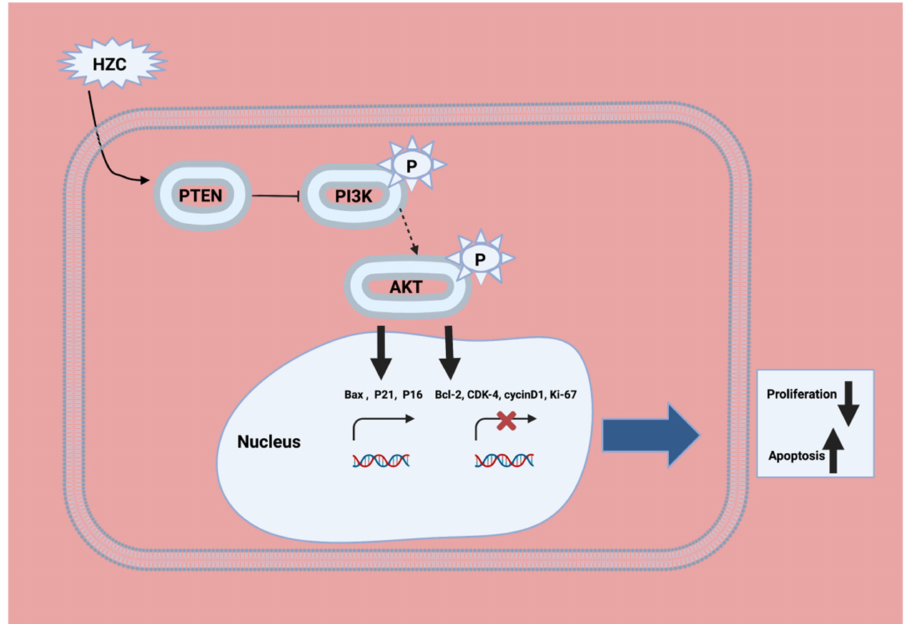
Figure 6. The mechanism of HZC in the HCC treatment model through the PTEN/PI3K/Akt pathway. HZC could inhibit activation of the PI3K/Akt signaling pathway by enhancing PTEN transcription, and then induce apoptosis of HepG2 cells via regulating the expression of apoptosis-related proteins (Modified from